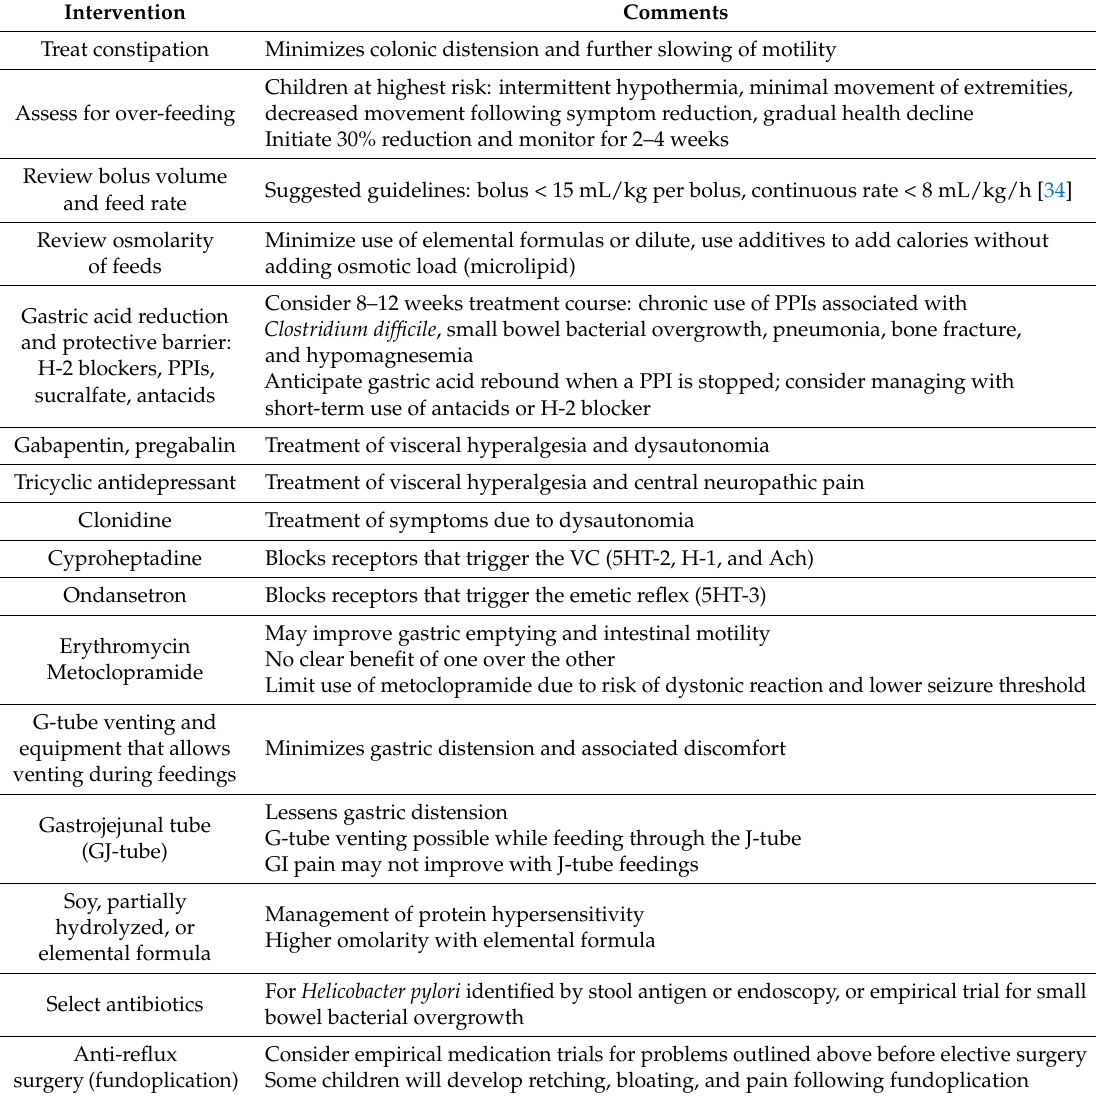
Table 2. Interventions for chronic retching, vomiting, and visceral